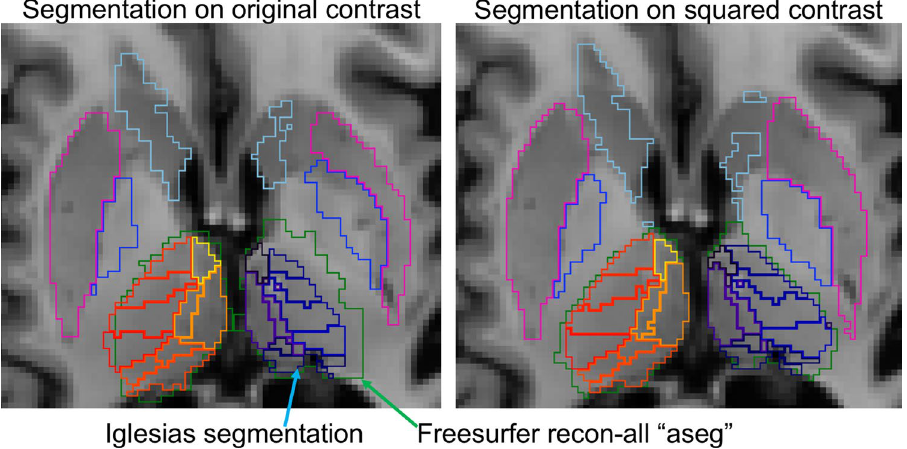
Figure 1. Representative freesurfer recon-all segmentation and Iglesias segmentation on original T1w contrast and squared T1w